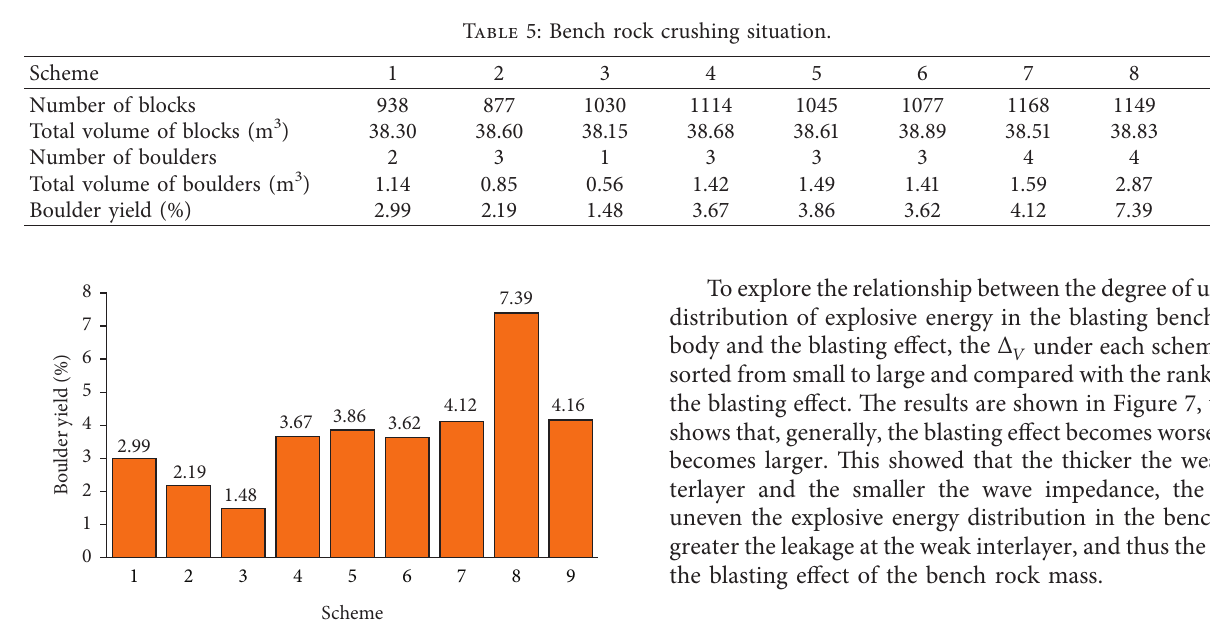
Figure 3: Statistics of boulder yield.